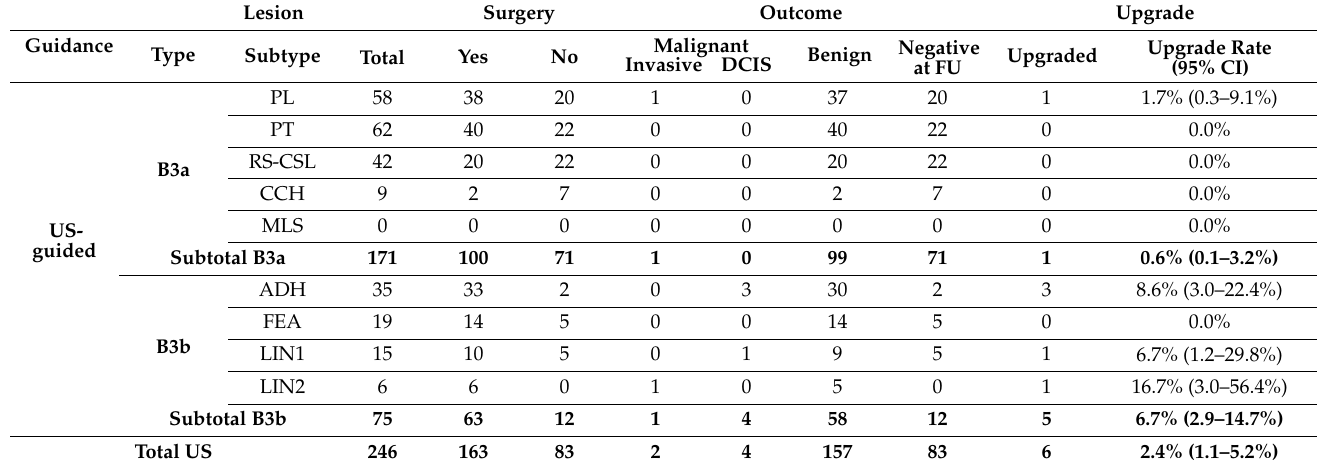
Table 3. Biopsy guidance-oriented analysis of the 604 B3 lesions according to surgery, outcome, and upgrade